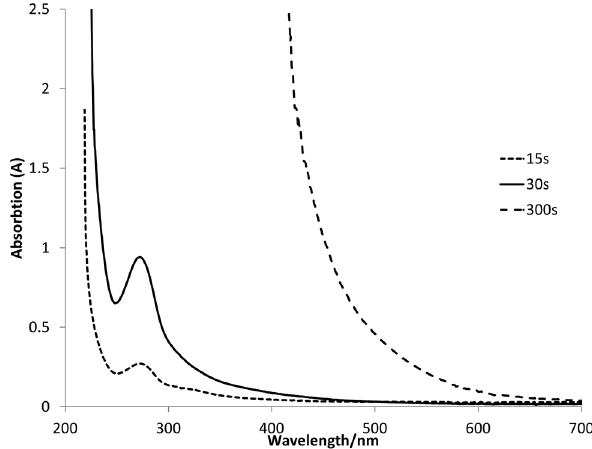
Figure 1: Development of UV - Vis absorbance of tea extracted at 77°C. Peak at 275 nm due to ca ff eine. Signal saturates between absorbance values of 2 and 4 on this spectrometer depending on